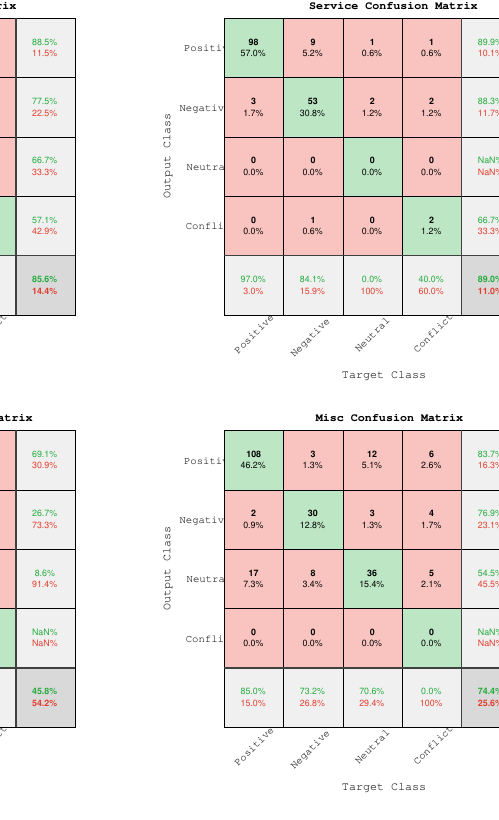
Figure 5. Confusion